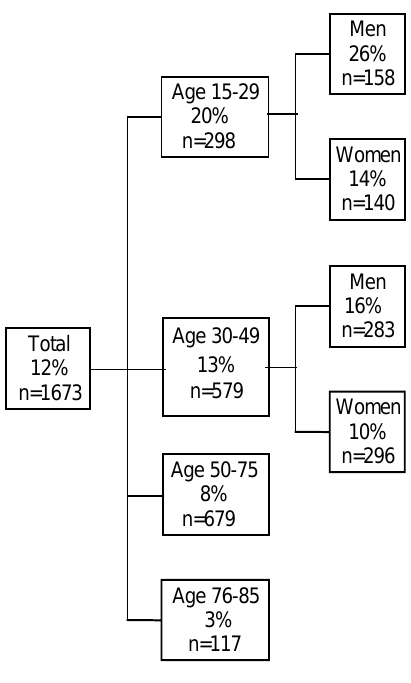
Figure 1. The Consistently Negative (Type